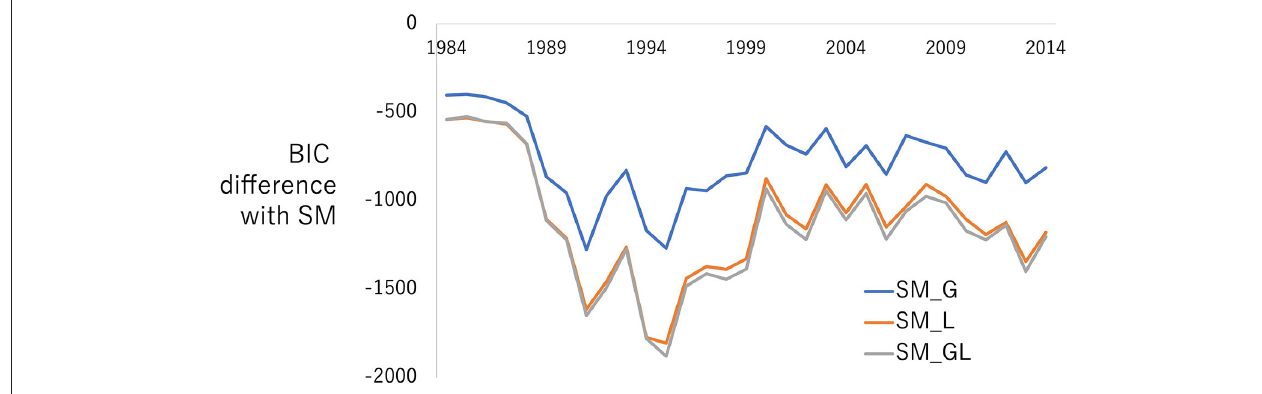
FIGURE 4 | BIC differences between SM and {SM_G, SM_L, SM_GL}. A larger negative value means better model accuracy relative to